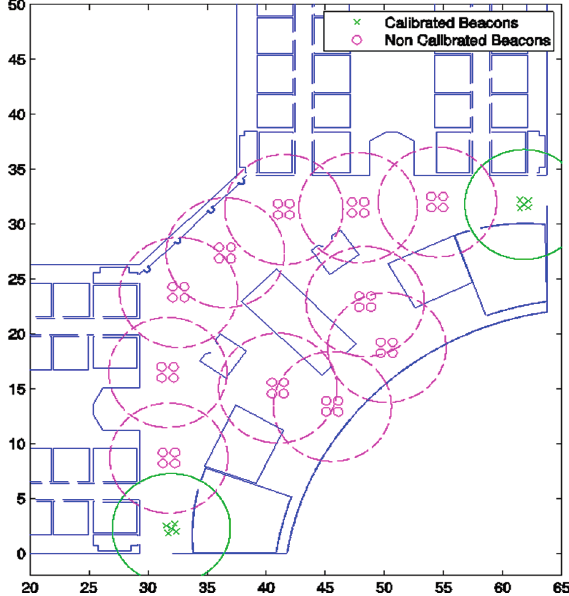
Figure 2. Simulated workspace based on the real plan of a